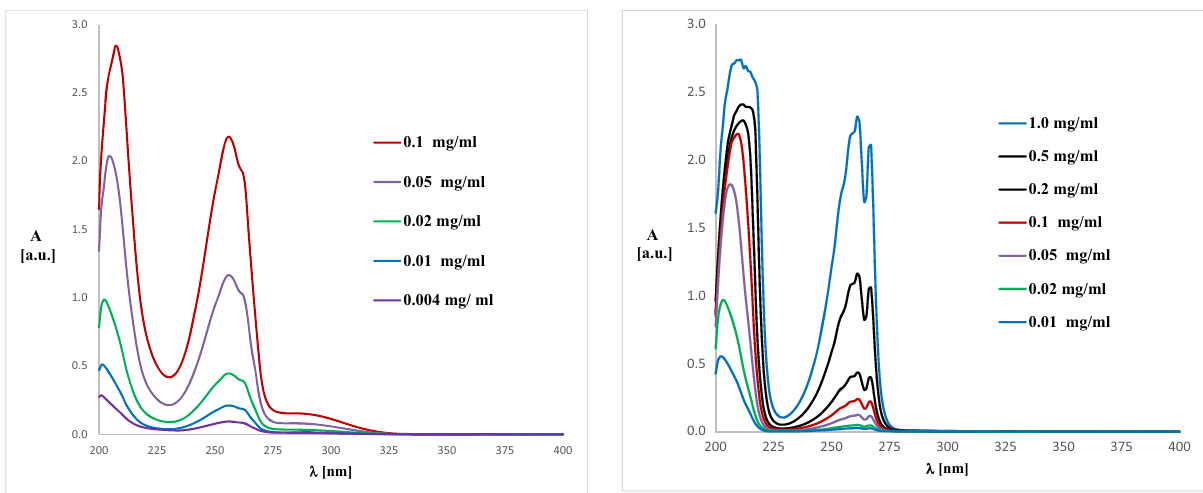
Figure 5: Experimental UV - vis spectrum of fl uconazole 2 registered in methanol at various concentrations.